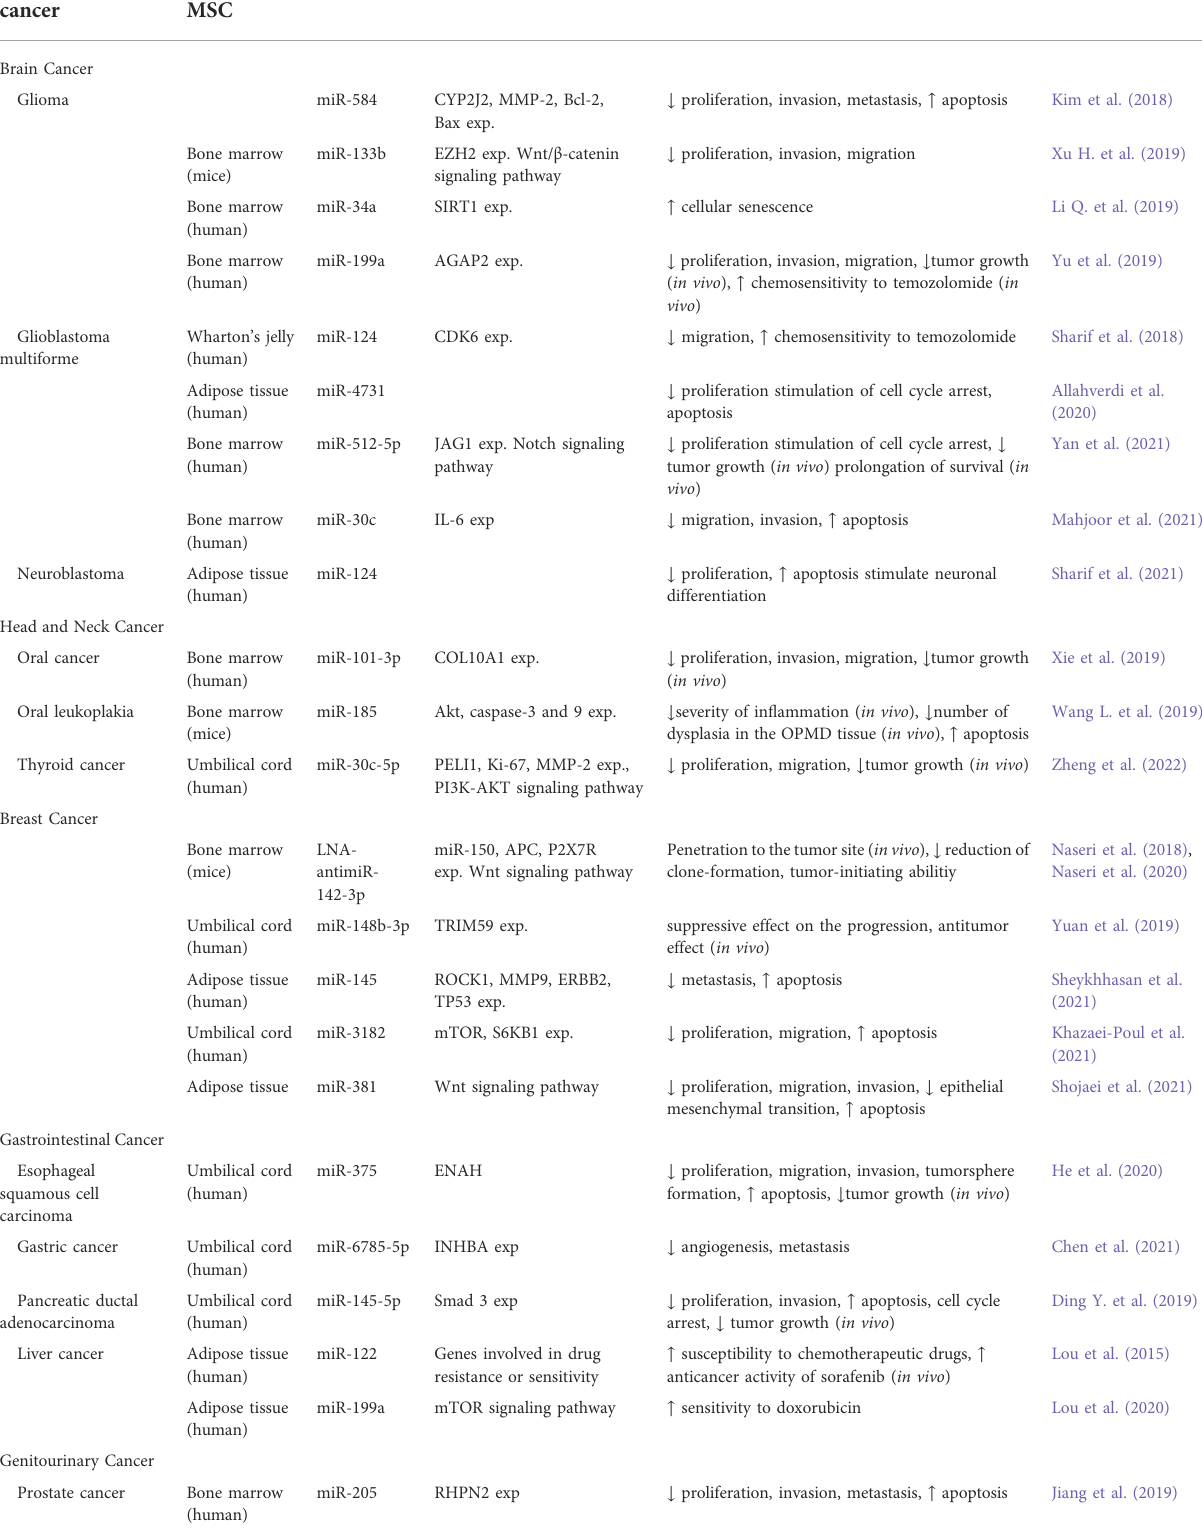
TABLE 2 Effects of miRNAs delivered by mesencymal stem cell-derived exosomes in different cancer